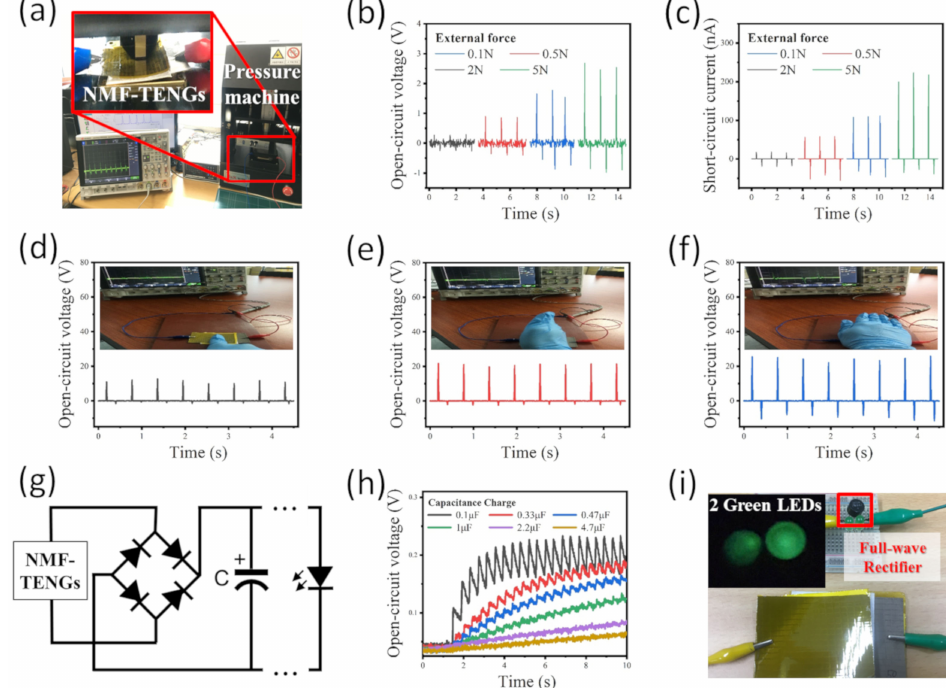
Figure 5. ( a ) Image of the measurement system. ( b , c ) Output voltage and current when applying external forces in the range from 0.5, 2, and 5 N. Output voltage with ( d ) finger, ( e ) blade, ( f ) palm tapping. ( g ) The bridge rectifier circuit. ( h ) E ff ect of capacitors on charging behavior. ( i ) Lightening green LEDs in the bridge rectifier